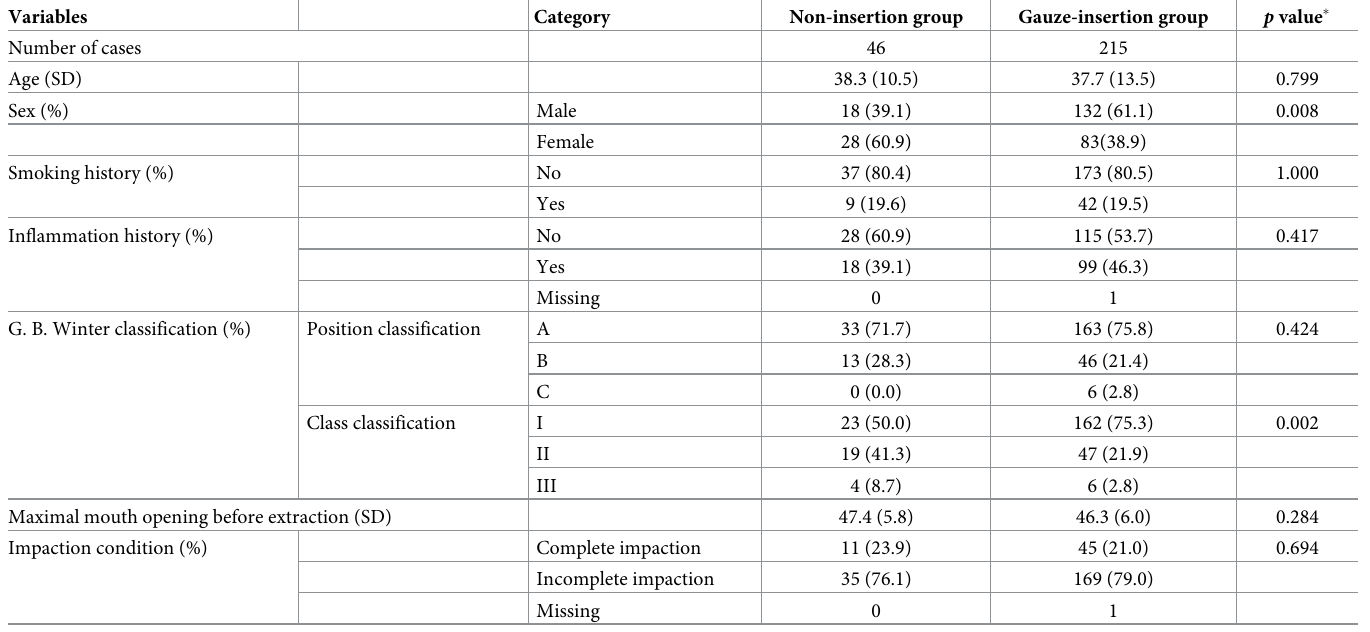
Table 1. Baseline characteristics of the gauze-insertion and non-insertion